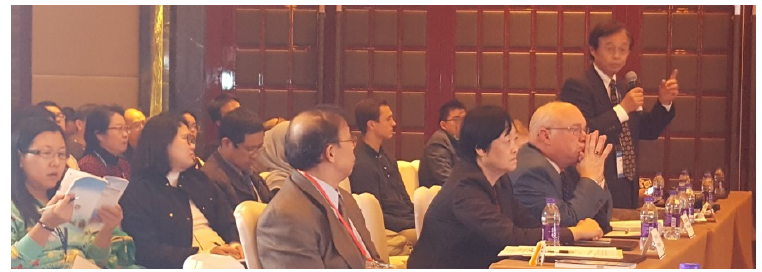
Figure 3. BIT’s 1st World Congress of Biomedical Engineering 2017.